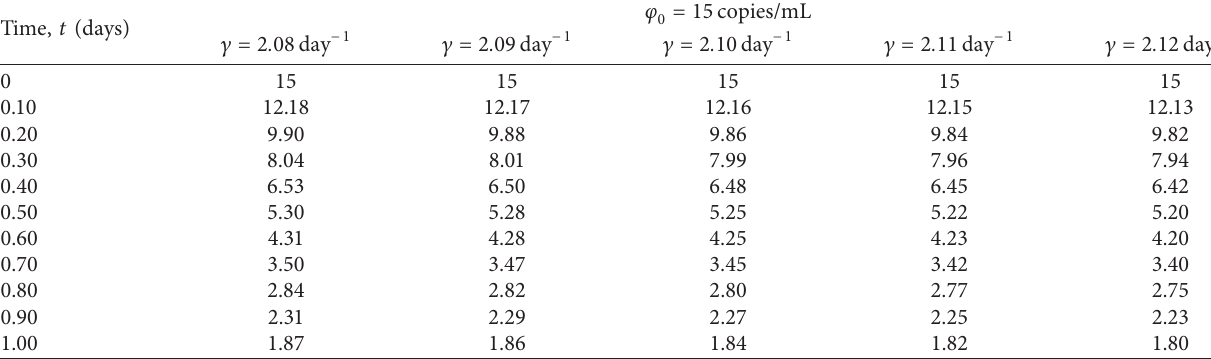
Table 1: Concentration of viral particles in plasma φ for different values of time t and rate constant of viral particle clearance c with initial � 15copies/mL (see Figure 1). concentration of viral particles in plasma φ 0